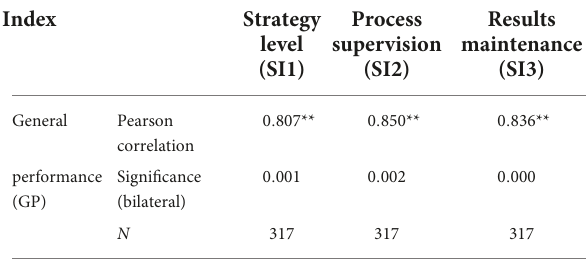
TABLE 5 Information strategy and corporation